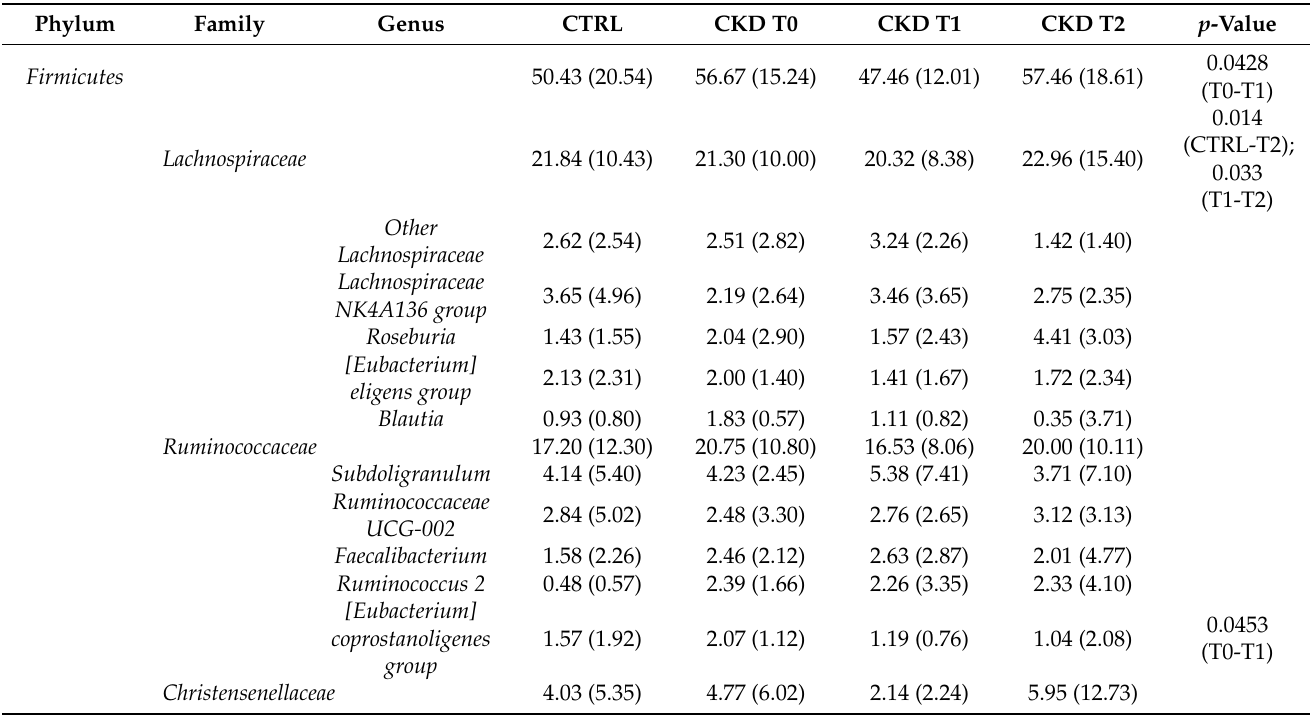
Table 3. Taxonomic abundances and significances. Average relative abundance and standard devia- tion at phylum, family, and genus phylogenetic